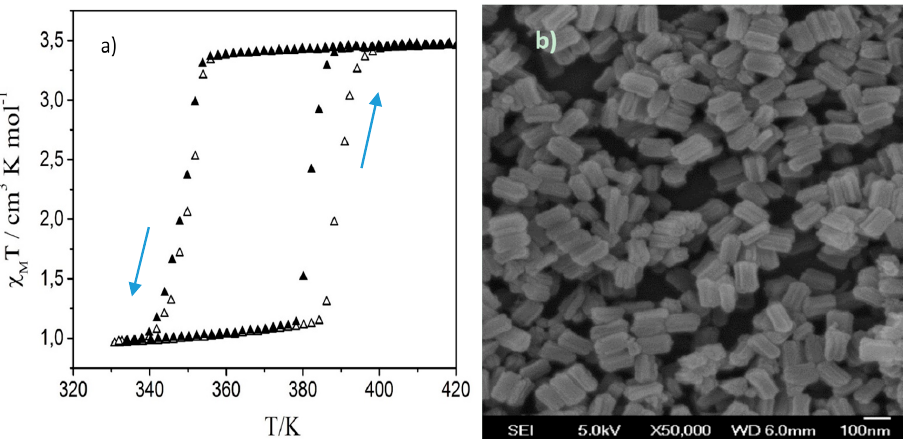
Figure 1. ( a ) Temperature dependence of the product of molar magnetic susceptibility and temperature for 1 over the first (open symbols) and second (closed symbols) thermal cycles. Heating and cooling are indicated by arrows; ( b ) Representative SEM image of the particles of 1.